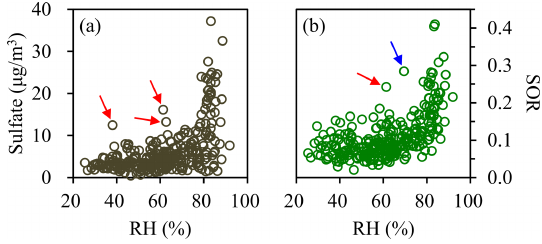
Figure 6. Comparisons of SOR between different RH levels, with results from different NO 2 ranges (below 30, 30–60 and above 60µg/m 3 ) shown separately. Results from both the 2018–2019 and 2019–2020 campaigns are included. The terms “D” and “H” indi- cate relatively dry (RH below 80%) and more humid conditions (RH above 80%), respectively.